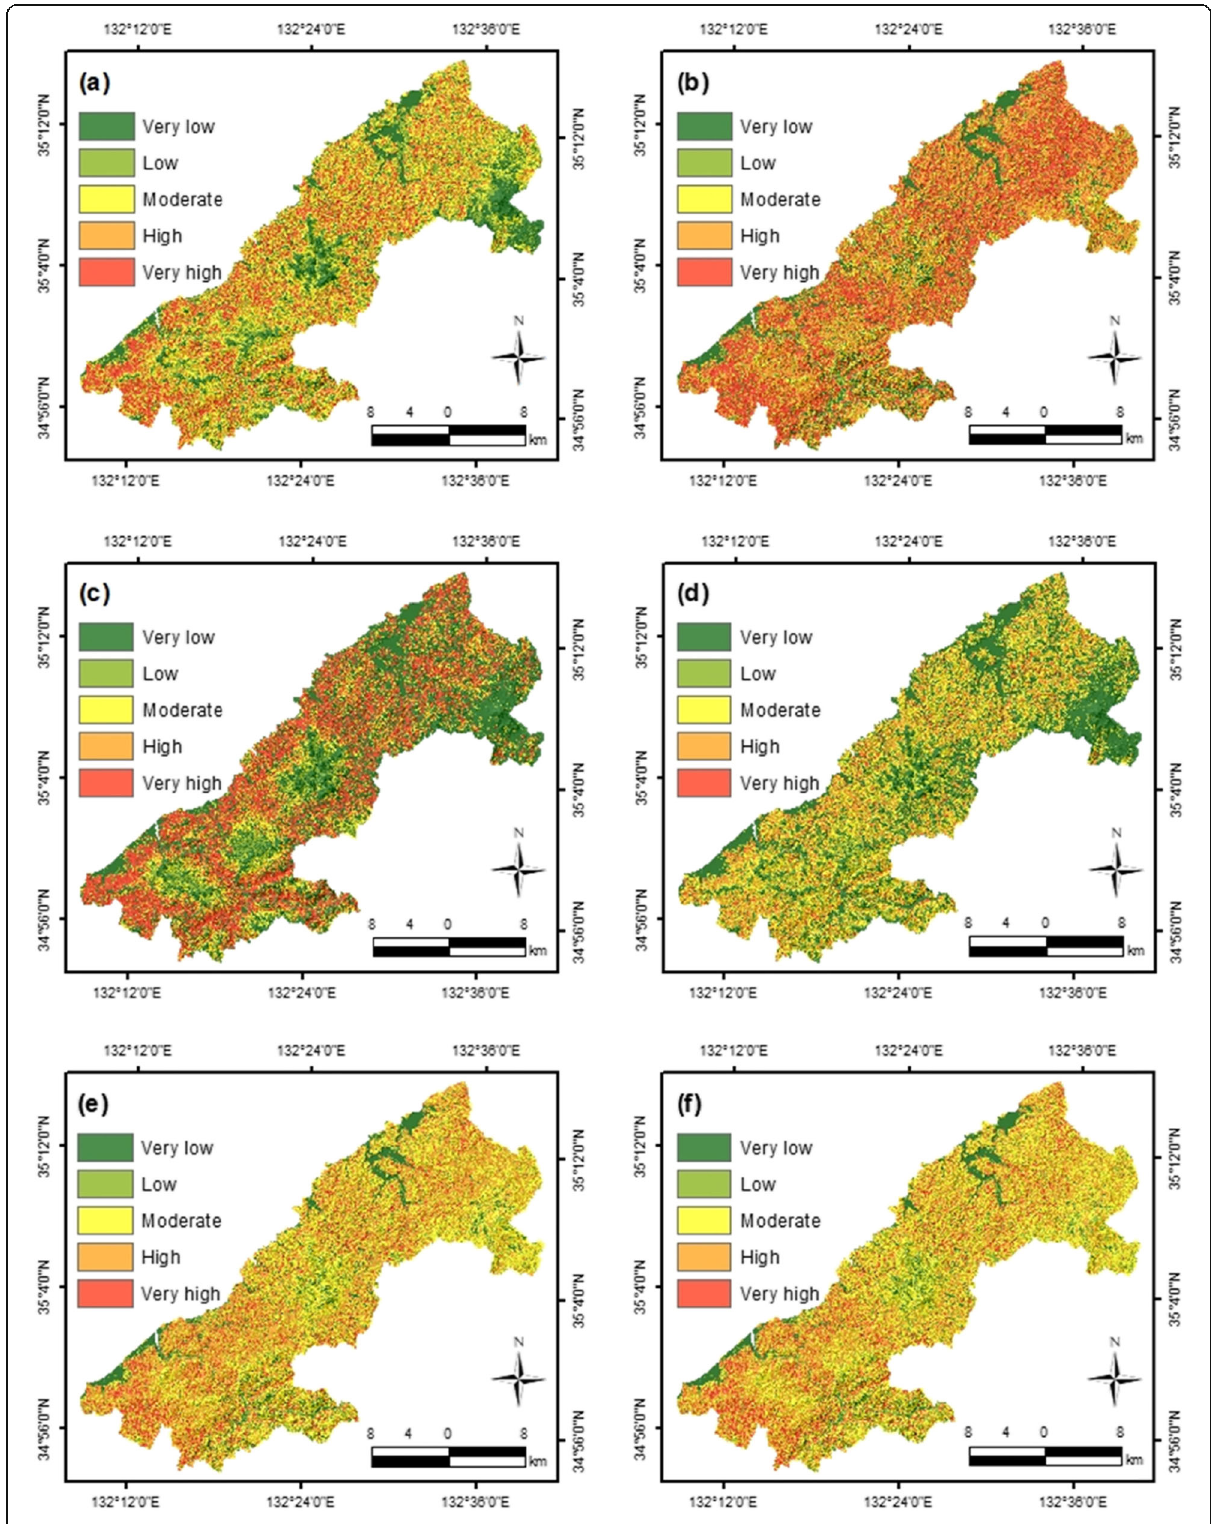
Fig. 9 Landslide susceptibility maps of Shimane prefecture using ( a ) support vector machine, ( b ) random forest, ( c ) stacked autoencoder, ( d ) sparse autoencoder, ( e ) stacked autoencoder combined with RF, and ( f ) sparse autoencoder combined with